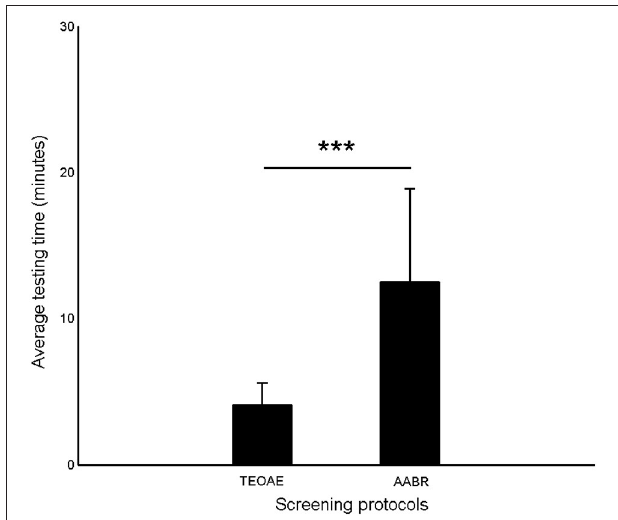
TABLE 6 | Results of hearing screening with TEOAE and AABR of neonates discharged within 48h after birth.